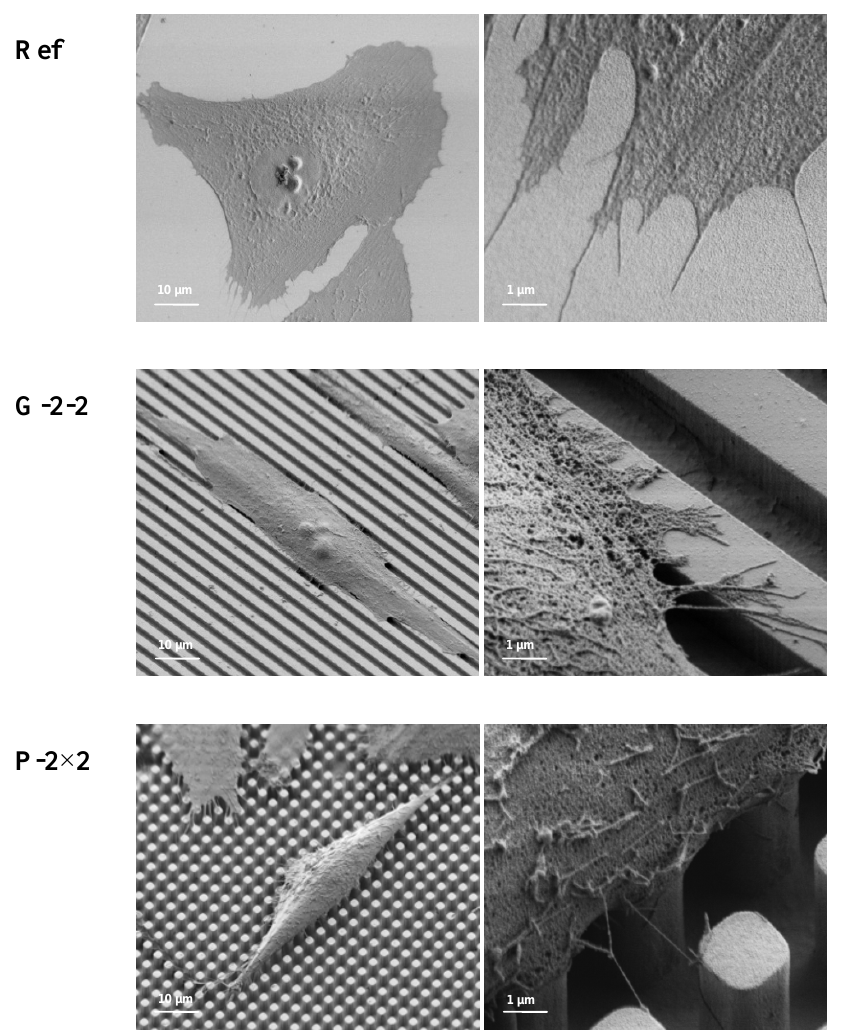
well spread and attach to the surface with the entire cell body. Interestingly, not only the grooved microstructure is able to guide the cells but also the regular pillar structure induces a cell elongation. Figure 3. Cell morphology of MG-63 osteoblasts on planar (Ref) and geometrically microtextured titanium surfaces after 24 h. FE-SEM images reveal that on the Ref, cells exhibit a flattened phenotype and are closely attached to the surface. In contrast, on the microtextured surfaces, cell adhesion is mainly restricted to the surface plateaus. In particular, on the grooved surface G-2-2, osteoblasts do not attach to the side walls and likewise on P-2×2, and on P-5×5 only the filopods of the cells reach the bottom (arrow). Moreover, on all microtextured surfaces, cell orientation is guided by the underlying surface micropattern (contact guidance), whereas on G-2-2 osteoblasts are aligned along the grooves and on P-2×2 and P-5×5, osteoblasts predominantly orient in 45° and 90° angles to the pillars (FE-SEM Supra 25, 30°, Carl Zeiss; bars: left = 10 µm, right = 1